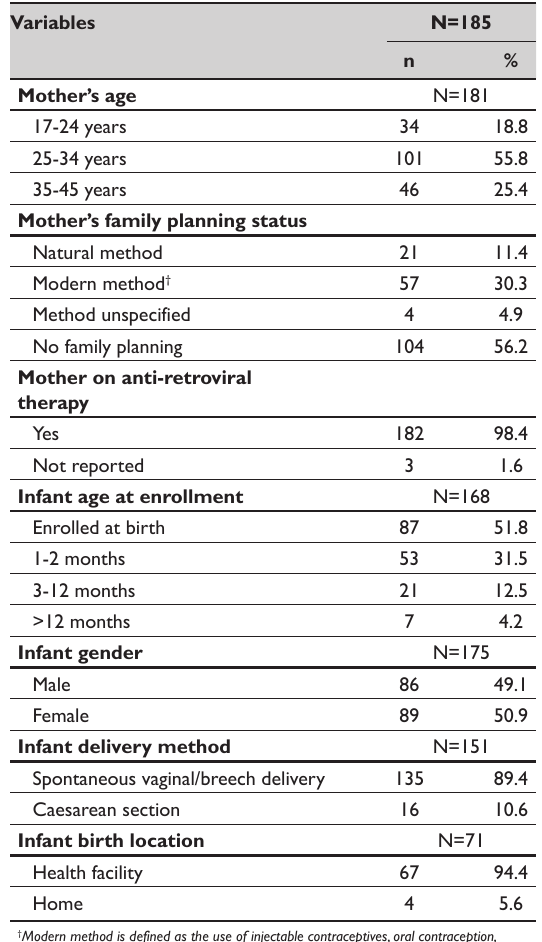
Table 1: Description of mother-infant at Table 2: Infant service utilization in the